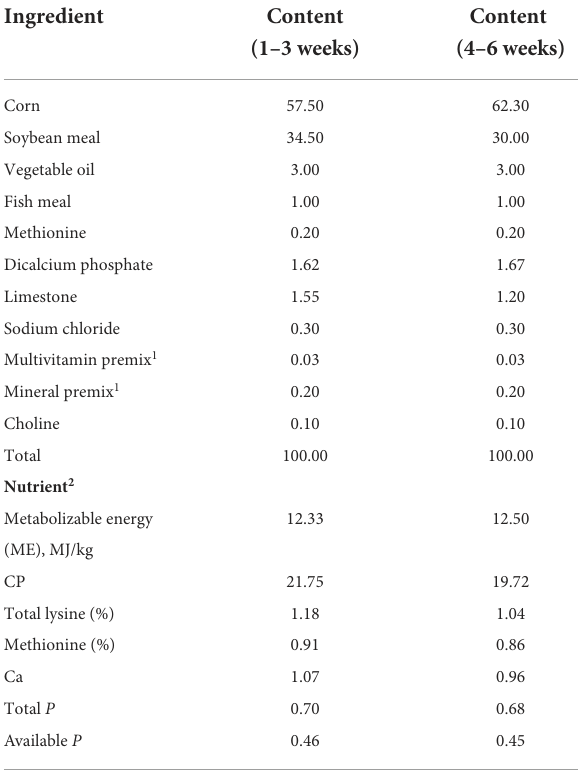
TABLE 1 Composition and nutrient levels of the basal diets (air-dry basis,